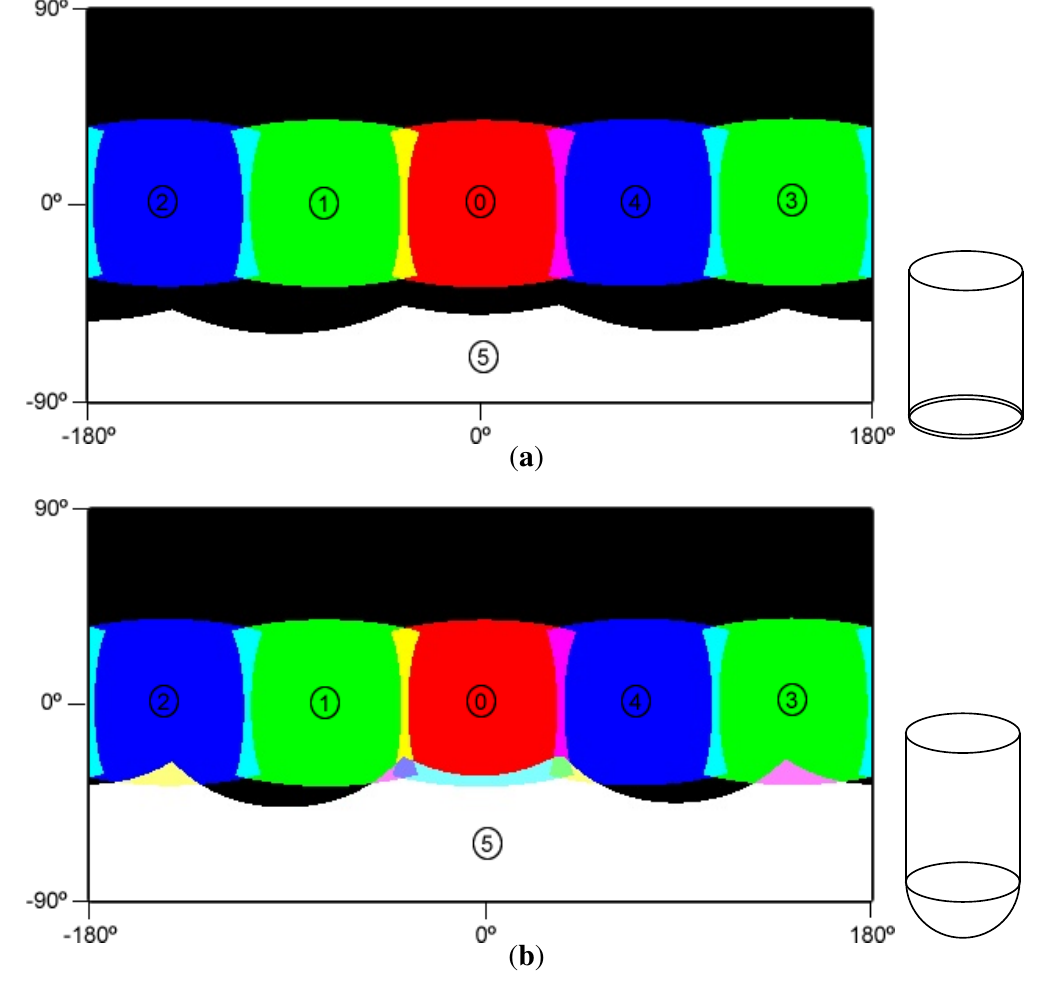
Figure 5. Equirectangular projection of the covered FOV at a 5-m distance in an underwater environment with different configurations. Each colored region represents the FOV of each camera (red, green, blue and white) and the areas of FOV intersection (other colors). ( a ) Projection of the covered FOV at a 5-m distance with a flat interface for the bottom camera; ( b ) projection of the covered FOV at a 5-m distance with a hemispherical interface for the bottom